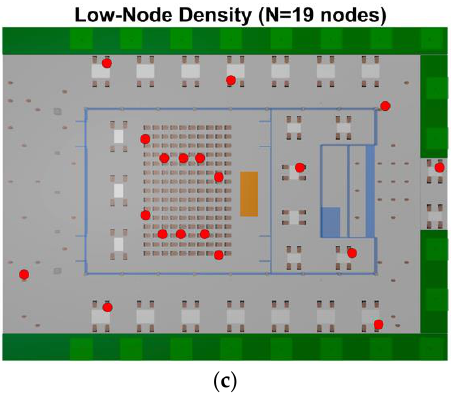
Figure 2. Aerial view of the scenario with the wearable’s location for the three different node density cases. Auditorium ceiling has been removed for illustration purposes, (a) high-node density, (b) medium-node density, and (c) low-node density.